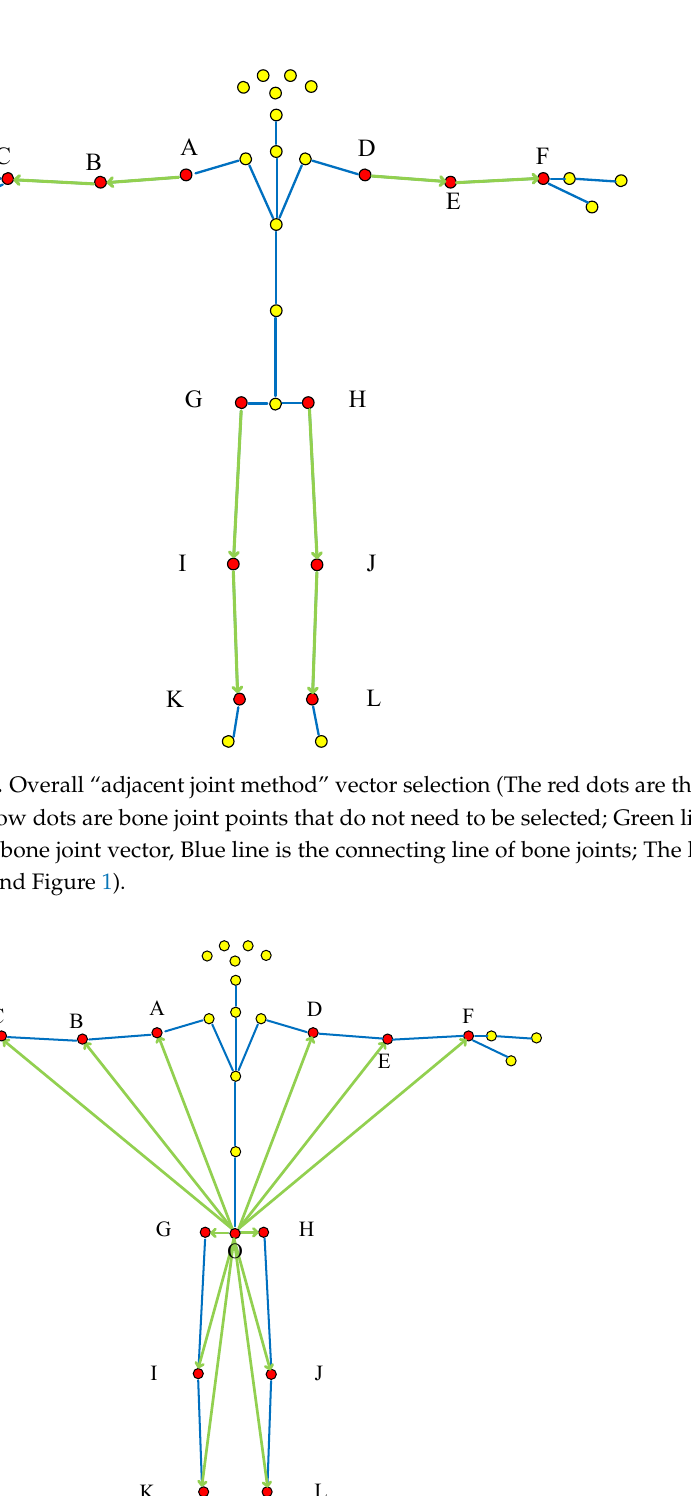
J Figure 5. Local “joint method” vector selection (The red dots are the selected bone joint, and yel- low dots are bone joint points that do not need to be selected. Green lines are selected joints, blue lines are not selected joints. The letters correspond to Table 1 and Figure 1).